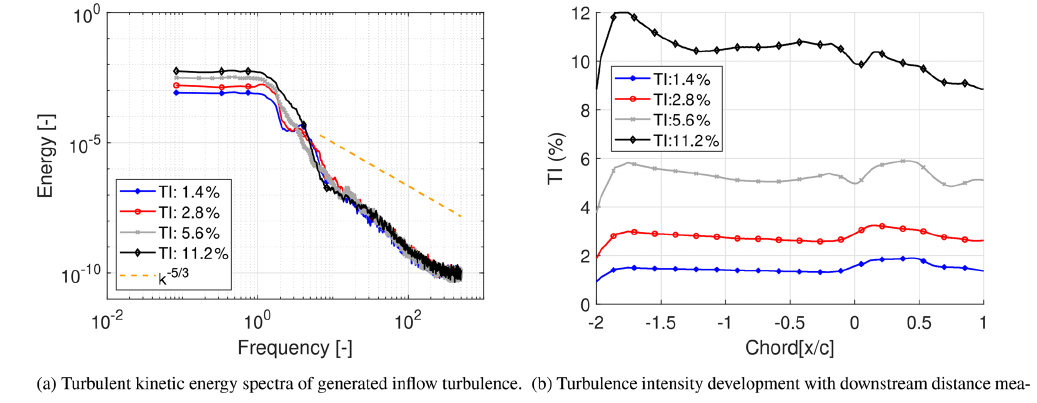
Figure 3. Inflow turbulence characteristics.